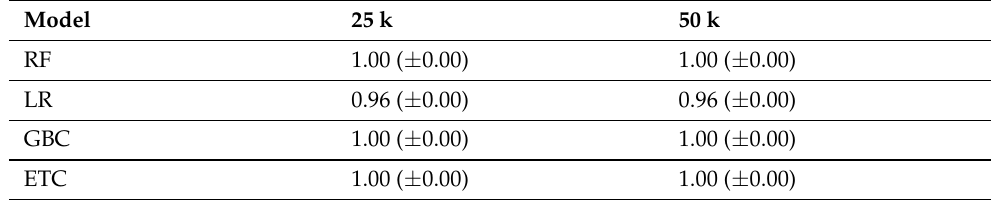
Table 11. Results using 10-fold cross-validation.